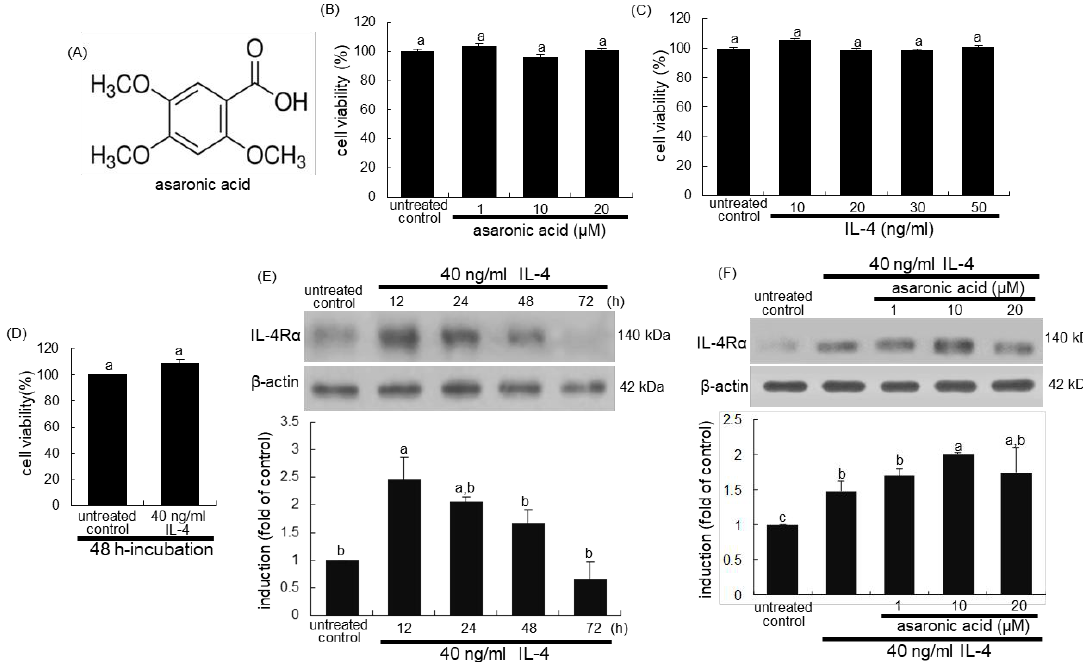
Figure 1. Chemical structure of asaronic acid ( A ), cytotoxicity of asaronic acid and IL-4 for up to 48 h ( B-D ), time-course response of IL-4 receptor IL-4Rα induction to IL-4 for up to 72 h ( E ), and further upregulation of IL-4Rα by asaronic acid ( F ). J774A.1 macrophages were exposed to 10-50 ng/mL IL-4 in the absence and presence of 1-20 μM asaronic acid for up to 72 h. Macrophage viability (mean ± SEM, n = 5) was measured by using 3-(4,5-Dimethylthiazol-2-yl)-2,5-diphenyltetrazolium bromide (MTT) assay and expressed as percent cell survival relative to untreated control ( B–D ). Cell lysates were subject to 8% SDS-PAGE and Western blot analysis with a primary antibody against IL-4Rα. β-Actin antibody was used as an internal control. The bar graphs (mean ± SEM, n = 3) in the panels represent quantitative results of the upper blot bands obtained from a densitometer. Mean values in respective bar graphs not sharing a same lower-case alphabet letter are significantly different at p < 0.05.